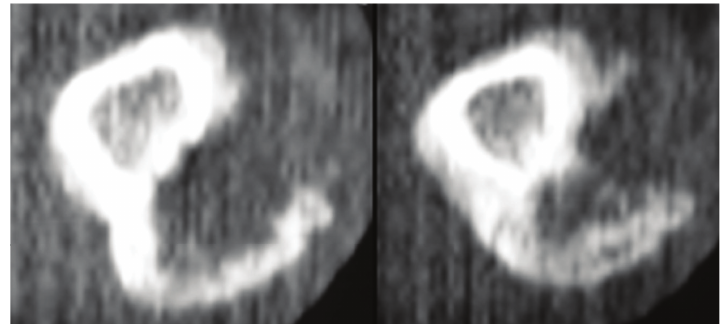
Figure 15: Careful axial CT scanning of the second metacarpal confirming there was not an area of continuity between the medullary cavity of the lesion and that of the underlying